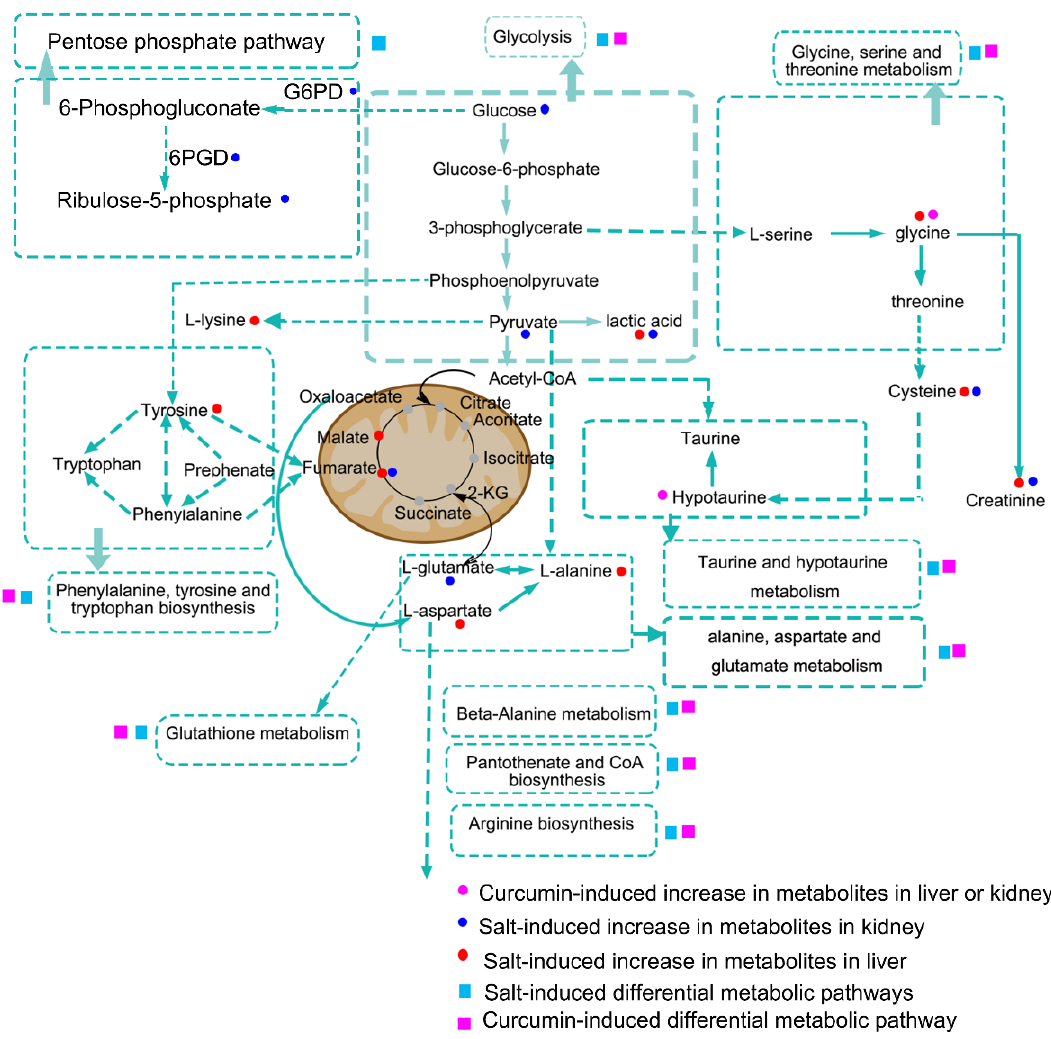
Figure 9. The schematic diagram of changes in the metabolic pathways after high salt intake in SS rats.